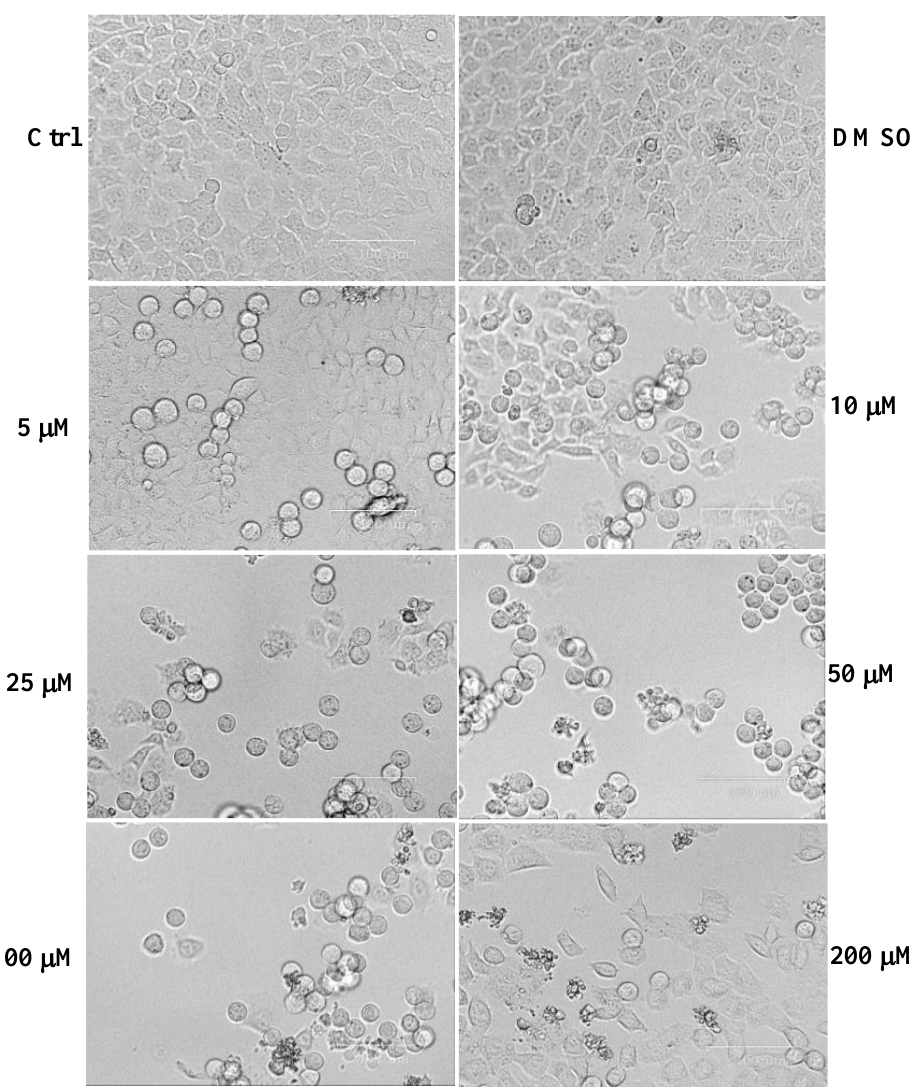
Figure 3. Representative images of phase contrast of control HeLa cells and cells treated for 24 h with DMSO (2%) and different amounts (5–200 µ M) of xanthomicrol 1 . Bar = 100 µ m. Clear cytotoxic activity is evidenced as a result of an increase in dosage.